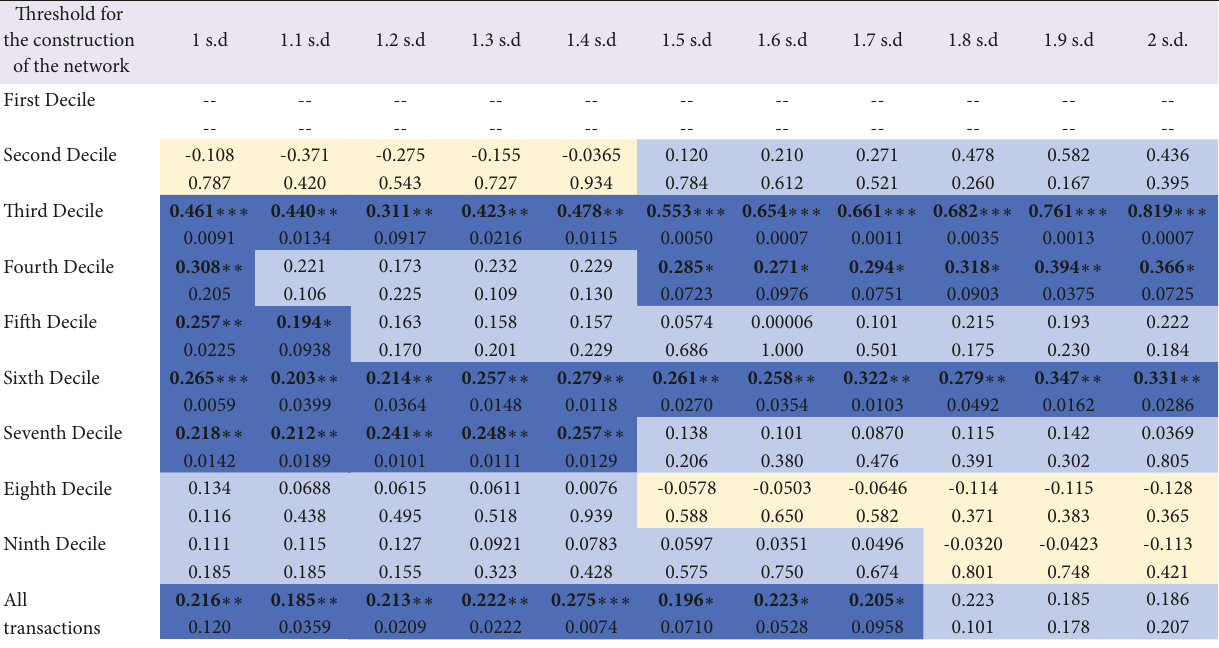
Figure 2: Estimated coefficients associated with the negative spatial dependence variable in Probit regressions with different thresholds defining the transaction network and different sizes of the IPSA shock used as the dependent variable in the Probit. Each regression controls for the variation of oil prices, dollar prices, VIX index, emerging market index, copperprices, 5-year credit default swaps S&P 500 stockindex, month, and year. The size of the IPSA jump is measured in standard deviations